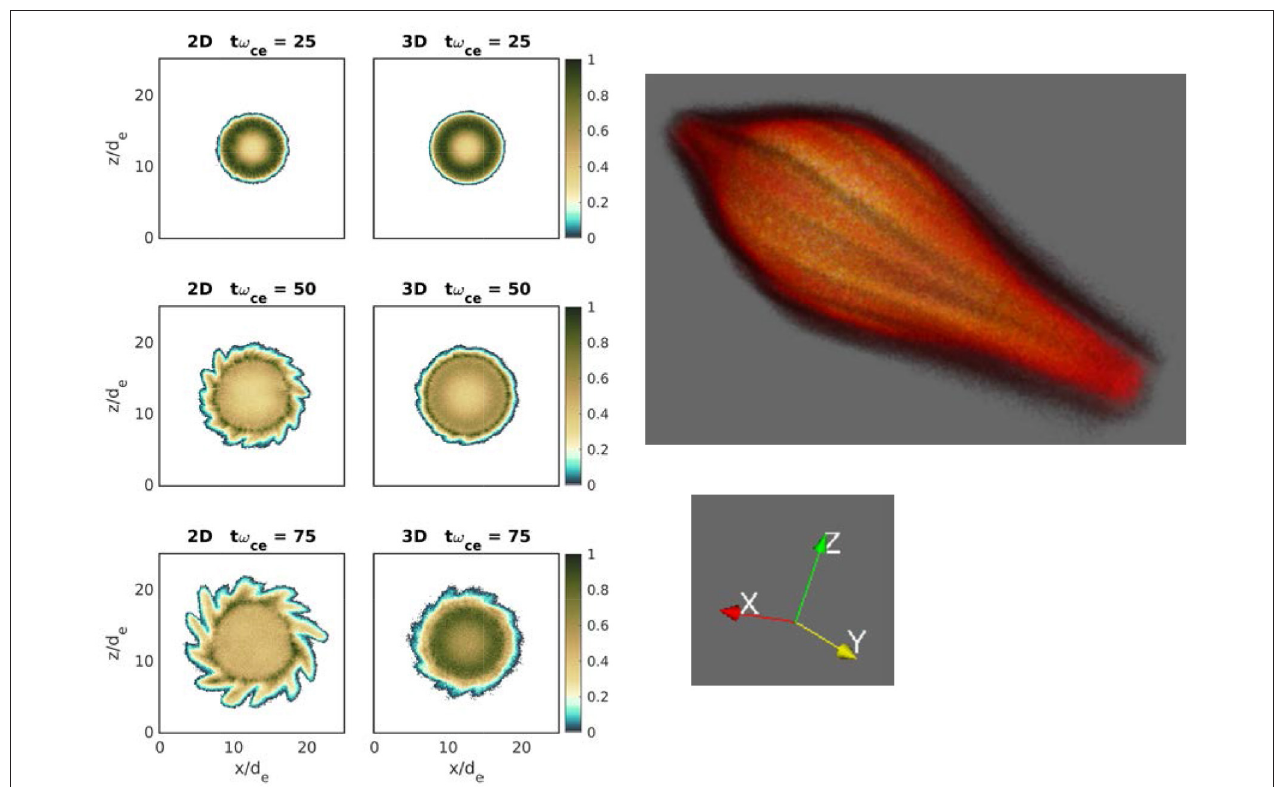
FIGURE 10 | Results of 2-D and 3-D VPIC particle simulations: left panels show 2-D debris electron density in the plane perpendicular to the magnetic field from (left) 2-D run and (right) 3-D run at three times (top row – ω ce t = 25, when the instability just begins to develop in the 2-D run; middle row – ω ce t = 50, when instability is fully developed in 2-D but just starting in 3-D; lower row – ω ce t = 75, when instability is fully developed). The right panel shows a 3-D picture of the debris electron cloud surface at this later time, ω ce t = 75, showing the cloud expansion along the magnetic field (y-direction) and how the surface perturbations would appear to an external